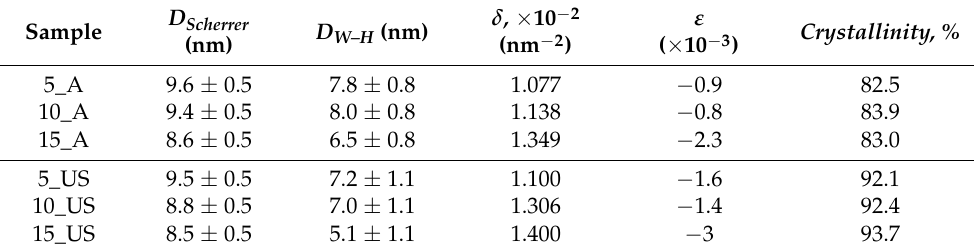
Figure 1. XRD patterns of the samples: ( a ) mesoporous TiO 2 obtained by ultrasound-assisted synthesis; ( b ) mesoporous TiO 2 obtained by stirring synthesis. Table 2. Structural features of the synthesized porous titania derived from XRD